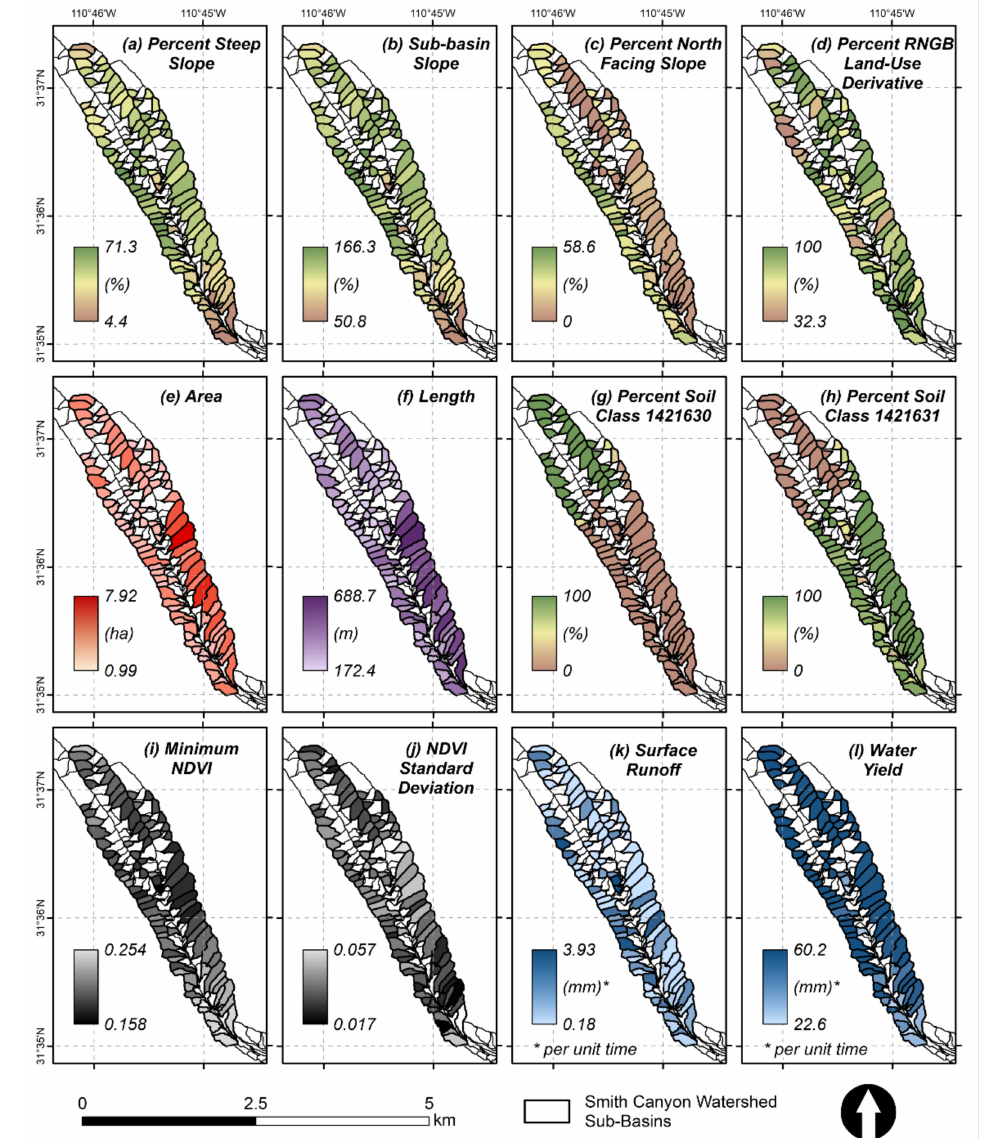
Figure 6. Watershed maps depicting the geographic distribution of values for each of the twelve selected spatial, biophysical, and hydrologic spatial variables ( a – l ) across each of the 91 selected sub-basins. Each of the selected variables have discernable geographic profiles (Figure 6, a through